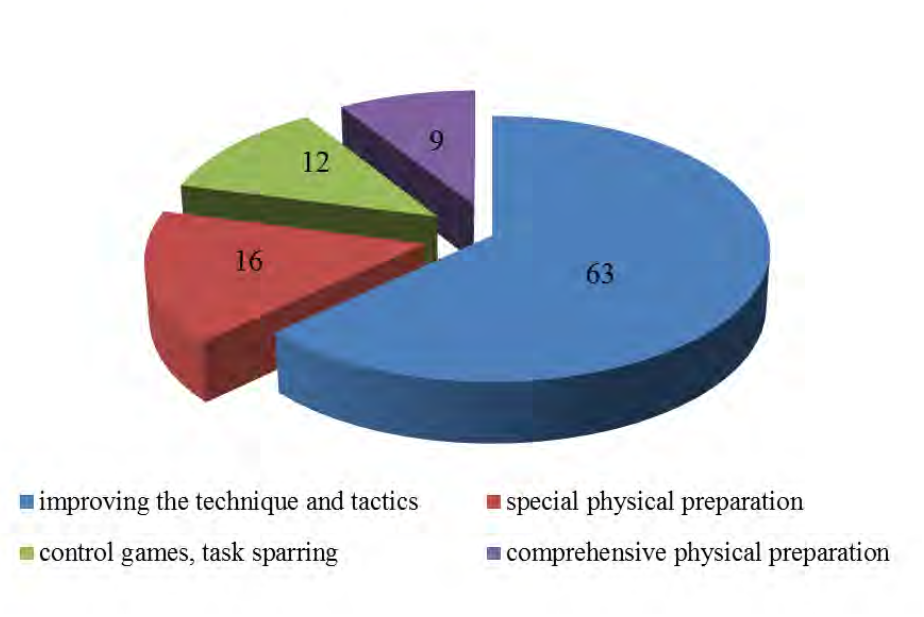
Fig. 2. Proportions of training measures in the intensification phase,